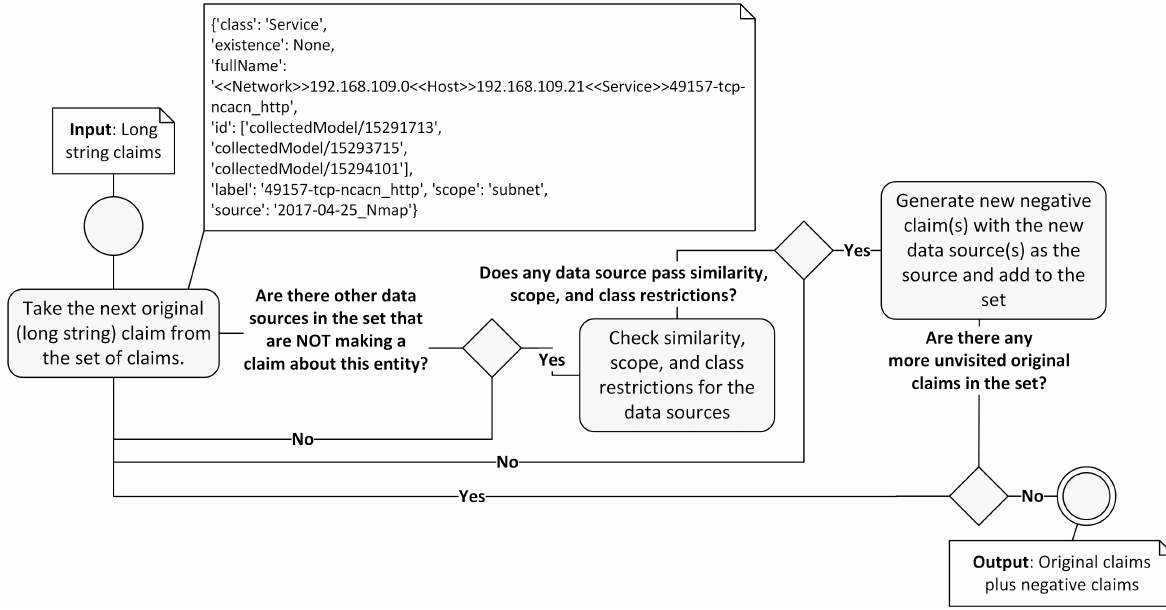
Figure 4. An algorithm for generating negative